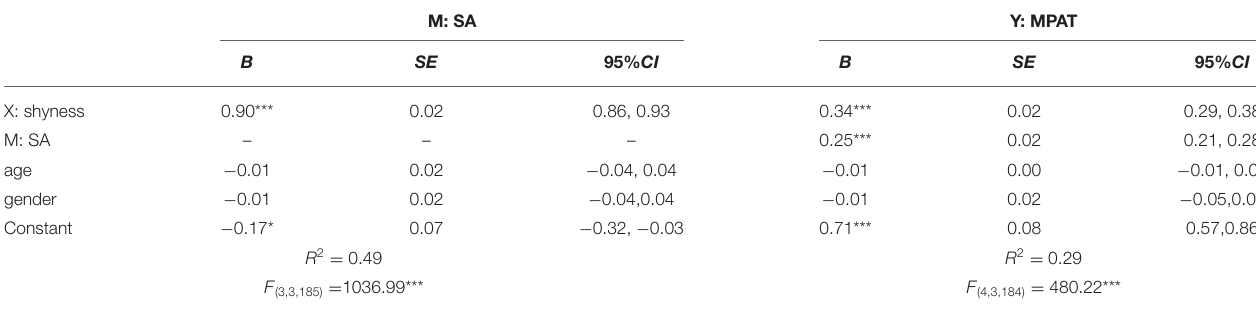
TABLE 3 | Results of mediation analysis of social anxiety.